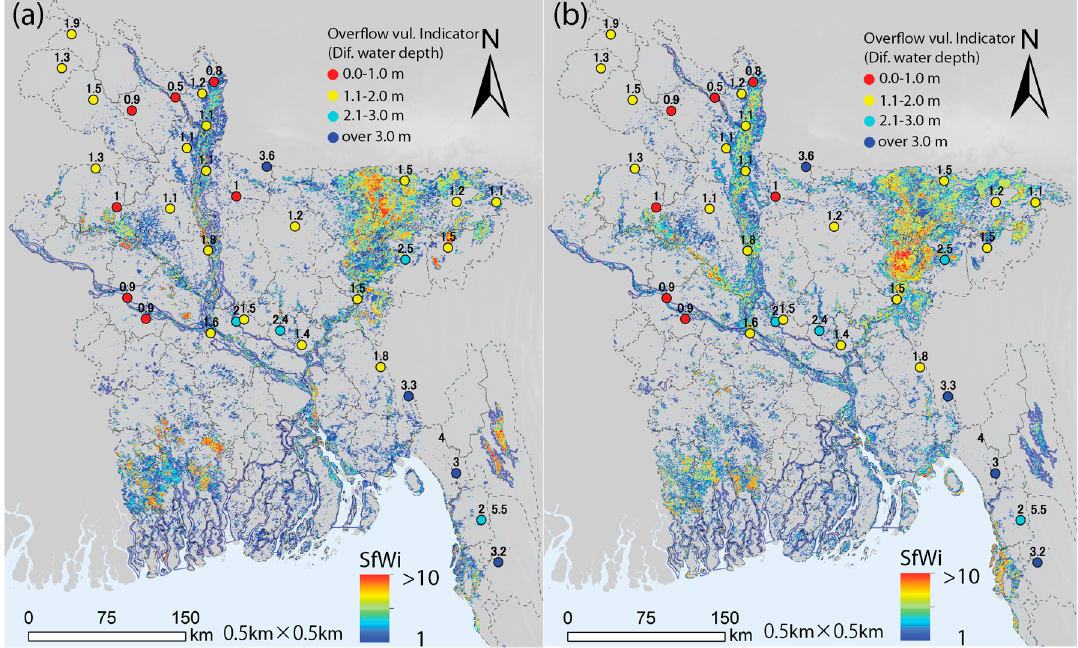
Figure 5. Nationwide annual flood mapping using SfWi across international river scale, GBM Rivers: the maximum flood inundation extent ( a ) before the peak water level; ( b ) after the peak water level on 6 September 2015.